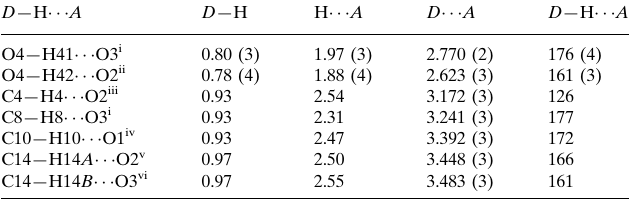
Hydrogen-bond geometry (A˚ , (cid:2)